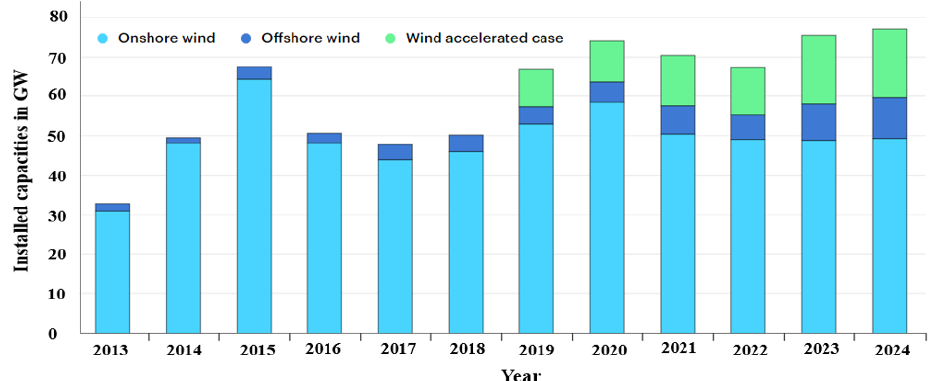
Figure 7. The annual additions of onshore and offshore wind power plant installations from the period 2013–2014. [63] (Data source: International Energy Agency (IEA), Renewables